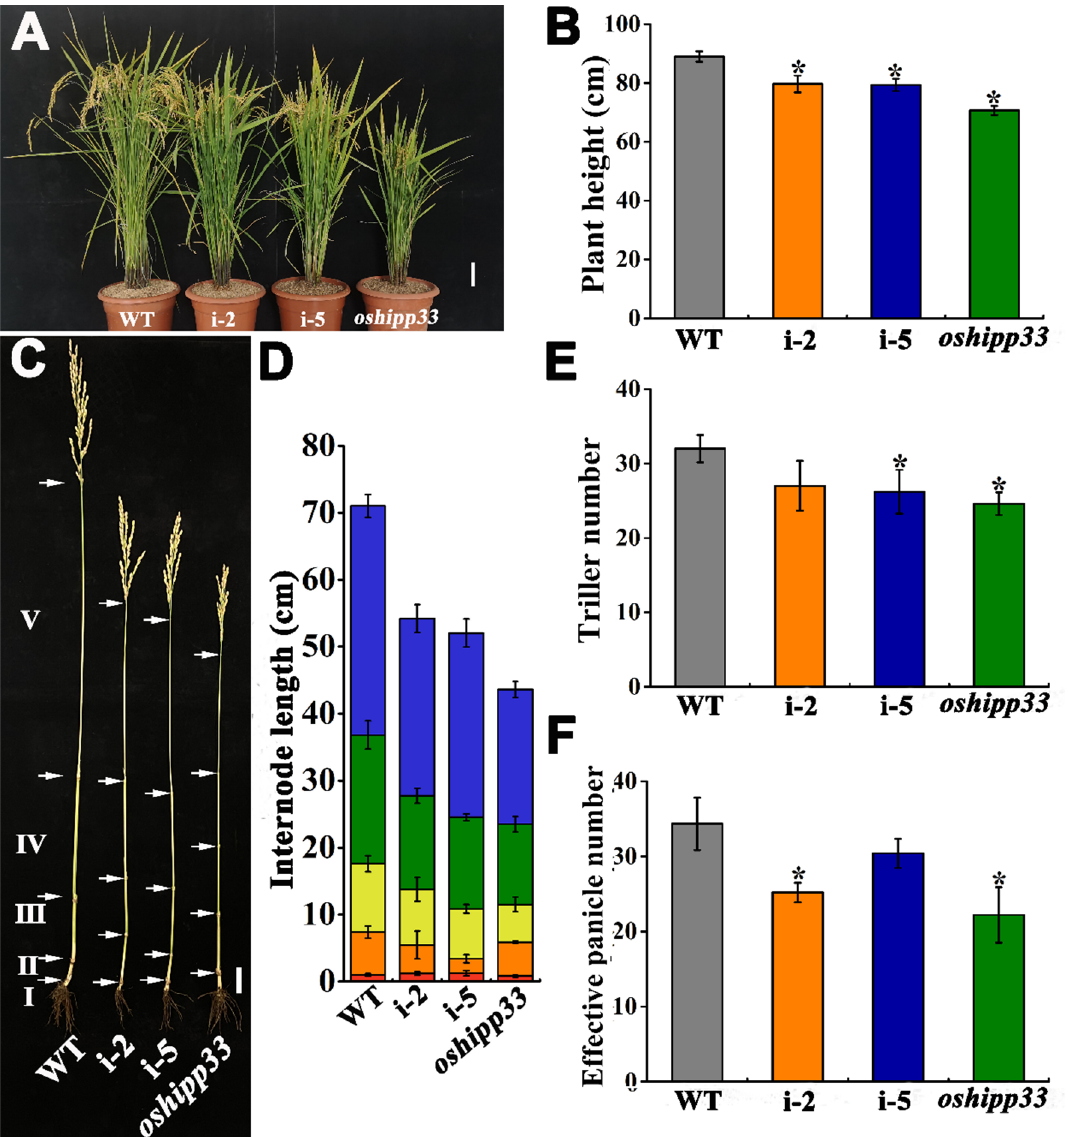
Figure 3. Morphological differences between OsHIPP33 mutant, RNAi (i ‐ 2 and i ‐ 5) lines and wild ‐ type (WT) at the maturity stage. The rice varieties were grown in the field under natural conditions for two successive year trials. ( A ) The phenotypes of WT, RNAi and OsHIPP33 (scale bars: 10 cm). ( B ) Plant height comparison of WT, RNAi and OsHIPP33 . ( C ) Stem structure of WT, RNAi and OsHIPP33 . The interval between the two arrows shows the length of internode (scale bars: 3 cm). ( D ) Internode length comparison of WT, RNAi and OsHIPP33 . ( E ) Comparison of tiller number per plant between WT, RNAi and OsHIPP33 . ( F ) Effective panicle number per plant comparison between WT, RNAi and OsHIPP33 . The vertical bars indicate the means of biological triplicates and asterisks show the significant difference between the mutant lines and WT ( p < 0.05).